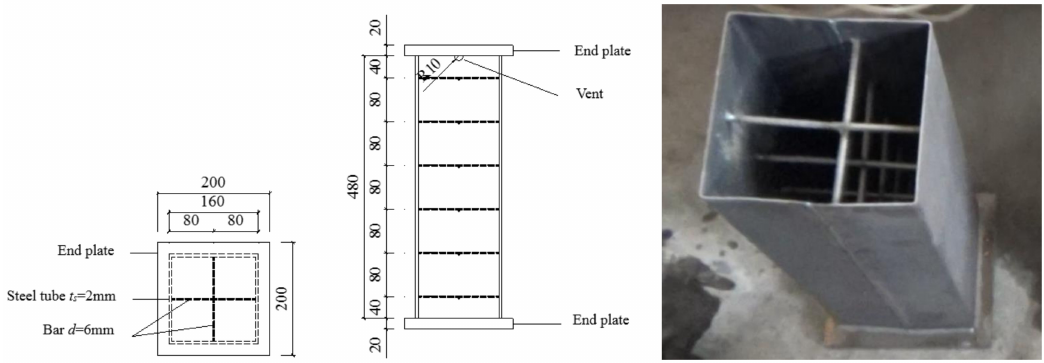
Figure 1. Design of short column